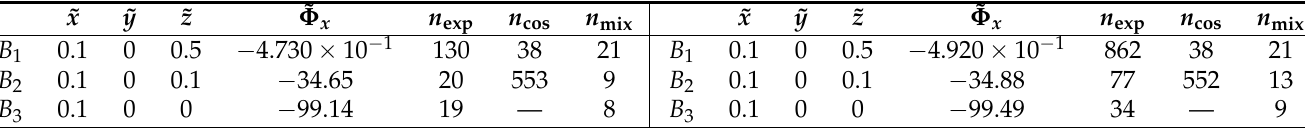
Table 4. Numerical values of the x -component of the rescaled force ˜ Φ x ≡ ∂ ˜ Φ / ∂ ˜ x as well as the numbers n exp , n cos and n mix for points B 1 , B 2 and B 3 for ˜ λ eff = 1 and ˜ λ eff = 3 in the left and right tables, respectively.